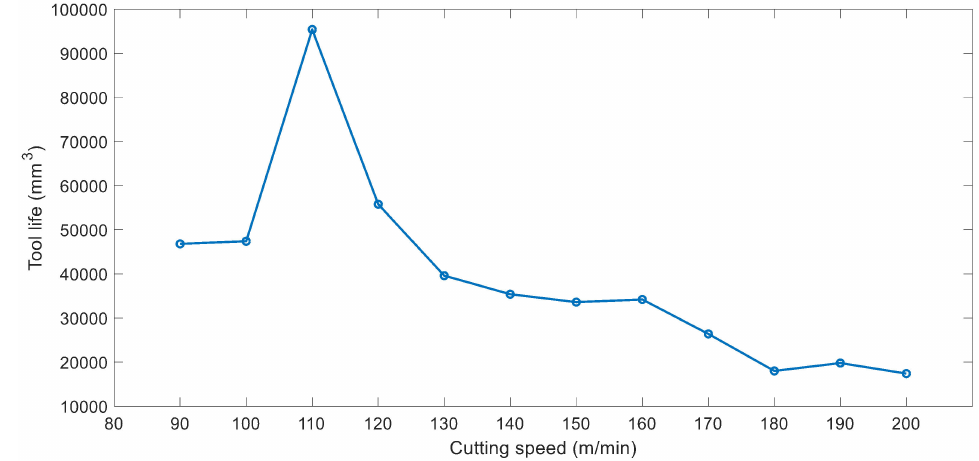
Figure 10. Graph of tool life (mm 3 ) versus cutting speed.